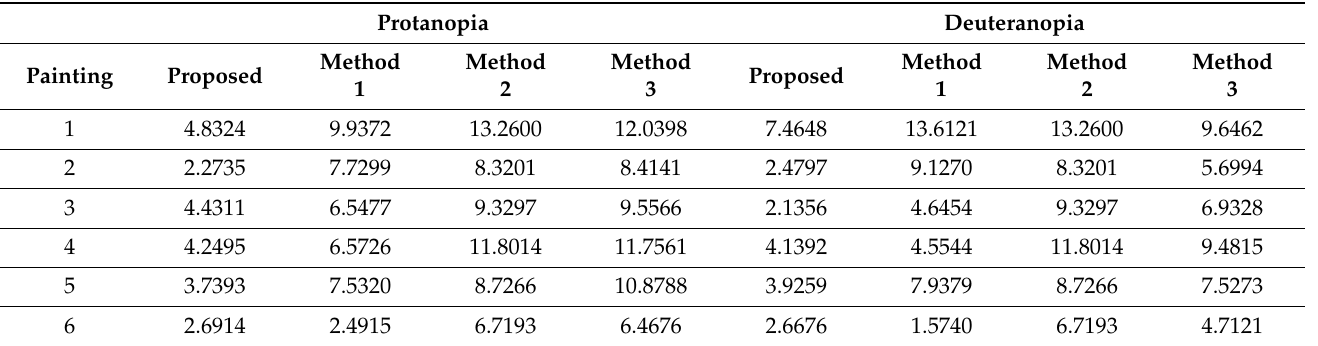
Table 2. Naturalness index (Jnat) values obtained by the four methods for protanopia and deuteranopia considering the paintings reported in Figure 5. Protanopia Deuteranopia